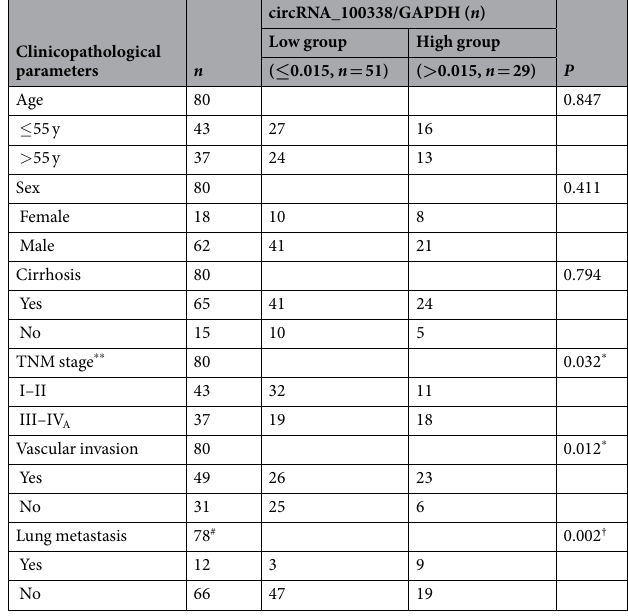
Table 2. Correlations between tumour circRNA_100338 expression level and clinicopathological parameters of HCC patients. NOTE: HCC, hepatocellular carcinoma; # Number less than 80 due to missing data. Significant difference: * P < 0.05, † P < 0.01. ** The TNM classification of malignant tumours (TNM) is a cancer staging system that describes the stage of a cancer that originates from a solid tumour with alphanumeric codes, using the size and extension of the primary tumour, its lymphatic involvement, and the presence of metastases to classify the progression of cancer. T: size or direct extent of the primary tumour; N: degree of spread to regional lymph nodes; M: presence of distant